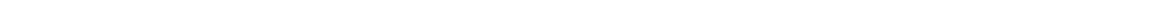
Fig. 7 Middle to late Miocene climate cooling steps coincident with unusual congruence of the Earth ’ s orbit. a Miocene to Pleistocene (16 – 0 Ma) benthic δ 18 O and δ 13 C records from ODP Site 1146, compiled from refs. 15 – 18 and this work. Blue arrows mark main phases of glacial expansion/deep water cooling; 3 pt smooth: 3 pt moving mean. Lilac shading marks global δ 13 C decline coincident with planktic δ 18 O increase and high-amplitude obliquity modulation of benthic δ 18 O. Blue shading marks fi nal stage of global δ 13 C decline. Light orange shading marks climate warming after 5.5 Ma. b Comparison of benthic ( C. wuellerstor fi and/or C. mundulus ) δ 18 O from ODP Site 1146 ( 15 – 17 and this work) with orbital parameters (eccentricity and obliquity from ref. 21 ) reveals similar sequence of climatic events during three Miocene cooling episodes with strikingly similar background orbital con fi guration. Blue shading marks cooling episodes following an extended period of high-amplitude variability in obliquity congruent with low variability in short eccentricity (gray shading). Light orange shading marks transient warming episodes coincident with high-amplitude variability in short